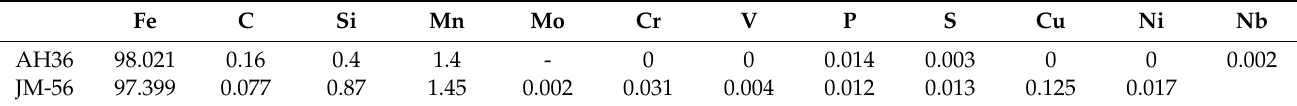
Table 1. AH36 steel and JM-56 wire chemical composition (wt.%).